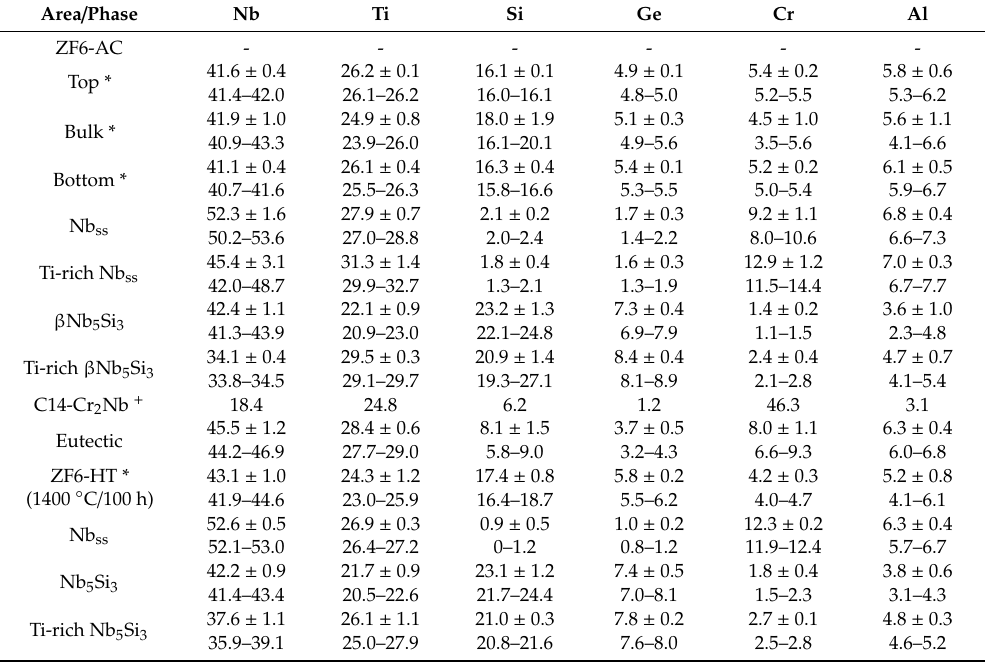
Table 2. Chemical analysis data (at.%) of as cast (AC) and heat treated (HT) alloy ZF6. Area / Phase